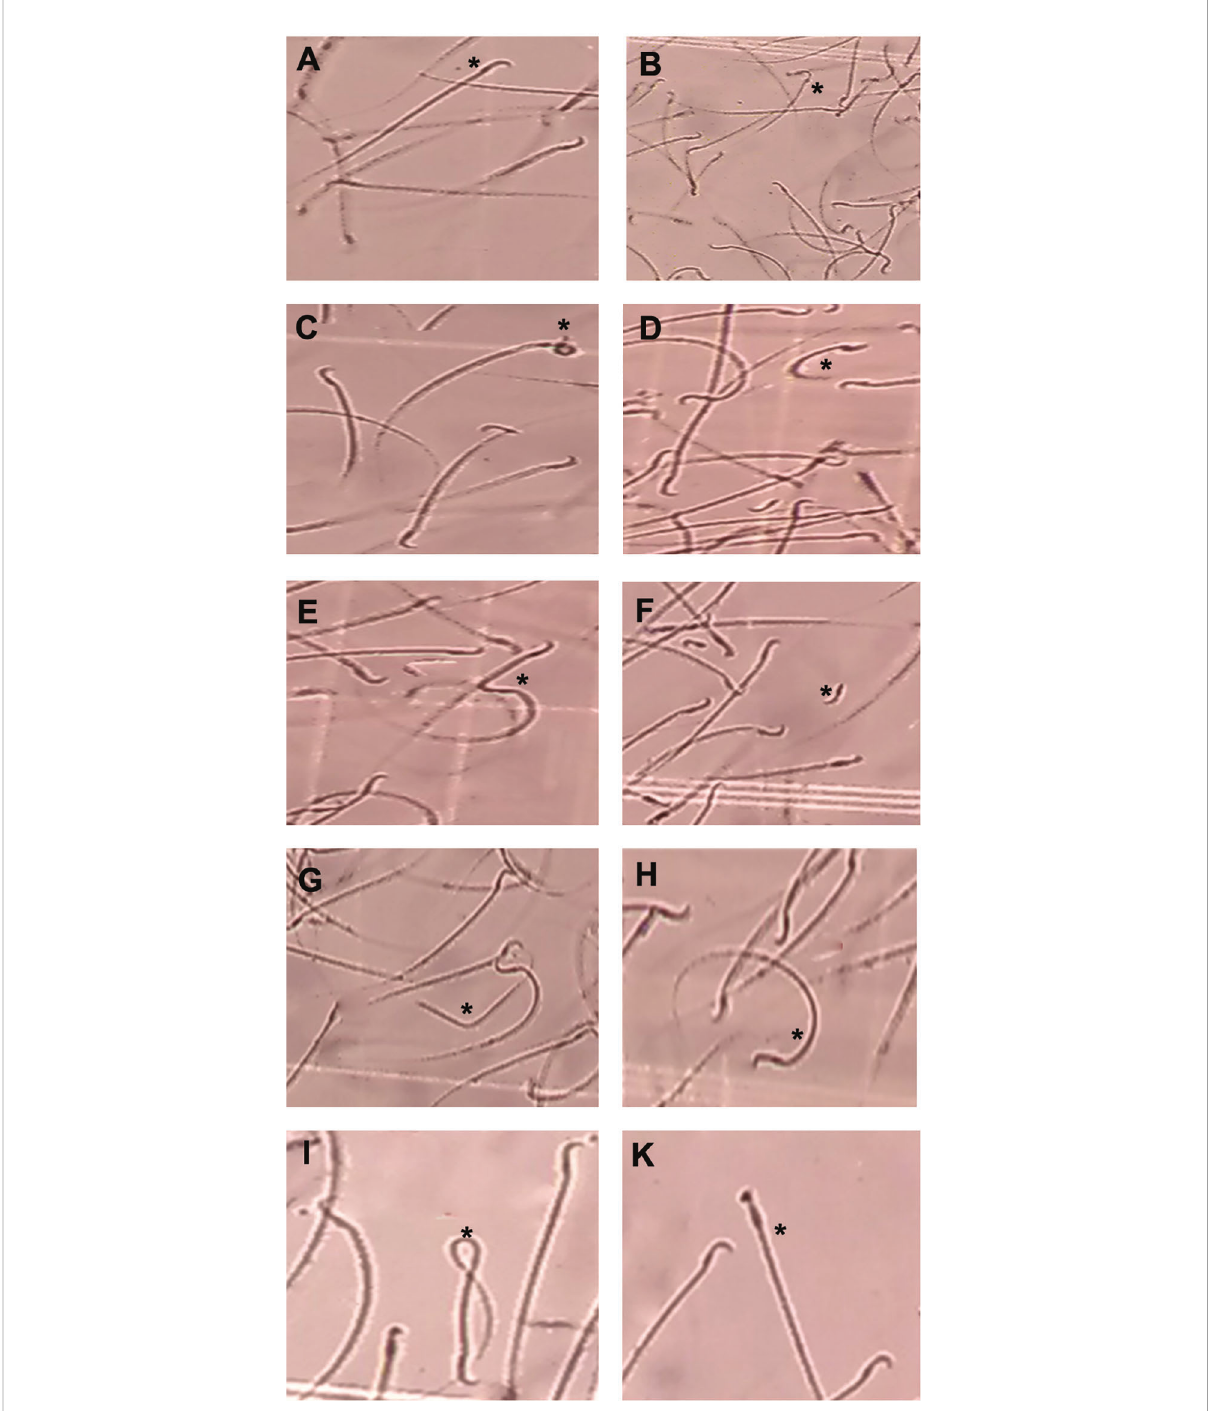
FIGURE 1 Microphotographs showing morphologically normal sperm and various sperm defects from the epididymis. (A) normal morphology, (B) Bent neck with cytoplasmic droplet, (C) head defects (large head), (D) tail defects (short and curve tail), (E) tail defects (broken tail), (F) detached head, (G) headless and broken tail sperm, (H) curve tail, (I) coiled tail, (K) : thick neck (magni fi cation